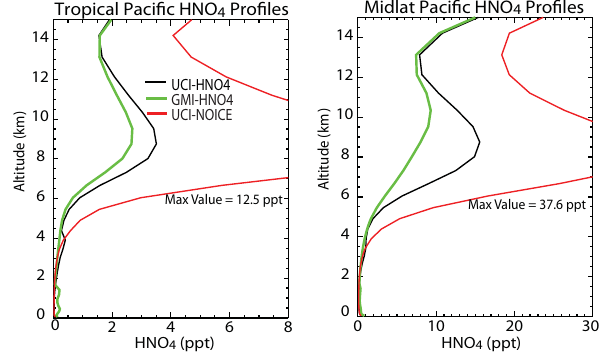
Fig. 7. Profiles of HNO 4 (ppt) from the UCI-HNO4 (black), GMI- HNO4 (green), and UCI-NOICE (red) simulations, averaged over the Tropical Pacific and Midlatitude Pacific boxes shown in Fig.